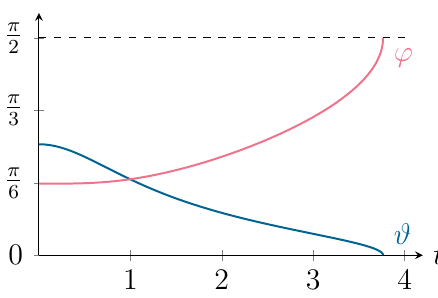
Figure 2 . Example of solution to the equations of motion (3.7) for φ = π/ 3 and θ = π/ 2 . ϑ ( t ) and ϕ ( t ) are given analytically in (3.24), they depend on the parameters J which are found numerically. In this example t